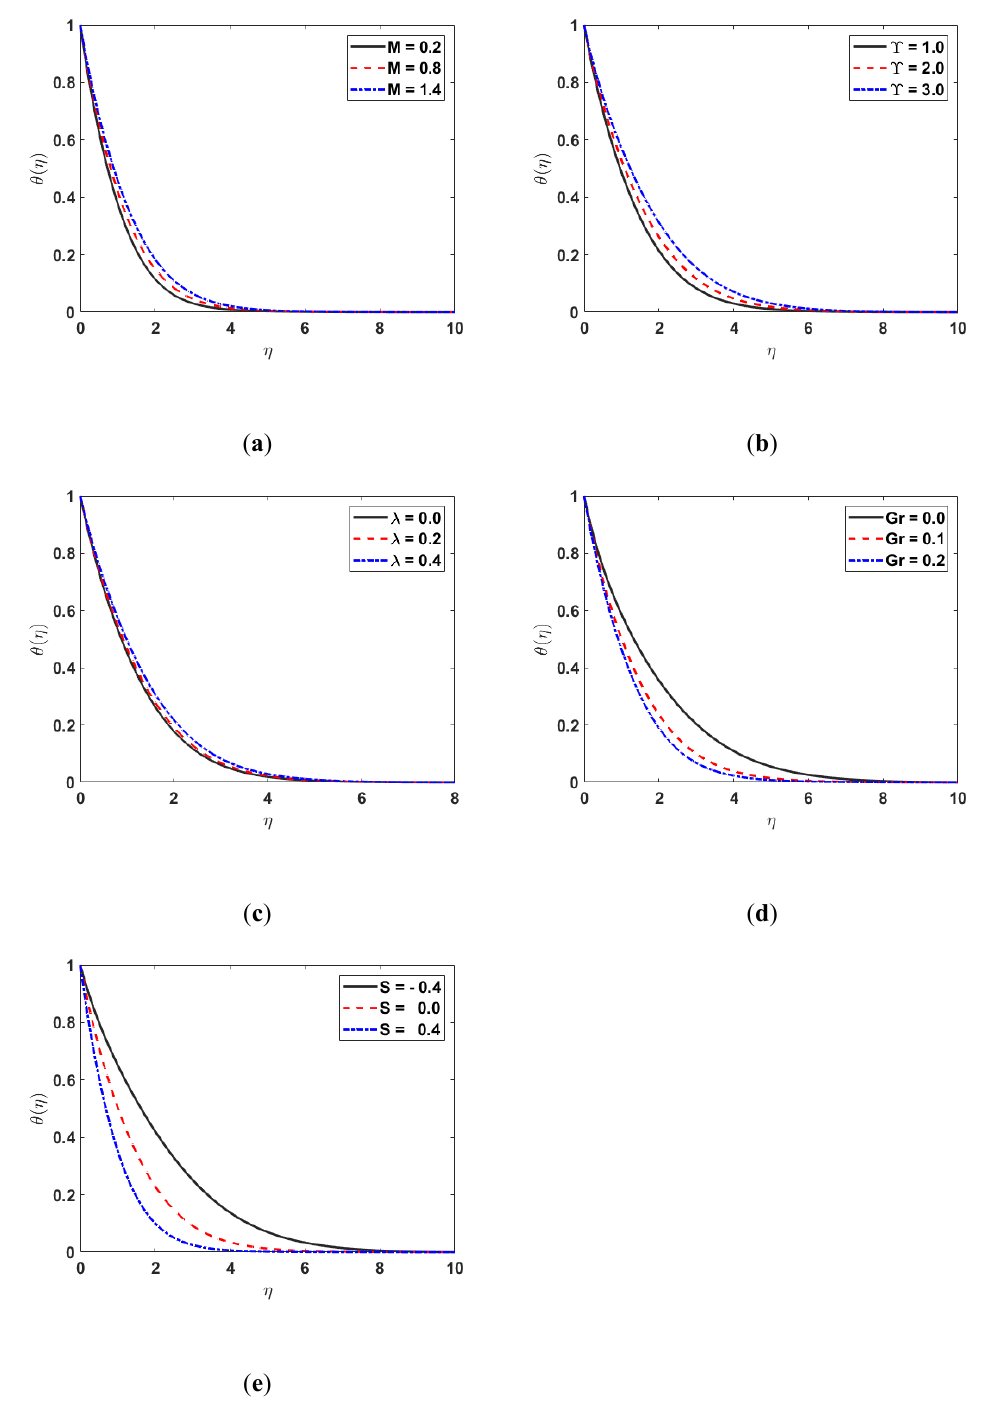
Figure 4. ( a ) 𝜃(cid:4666)𝜂 ) for different values of 𝑀 ; ( b ) 𝜃(cid:4666)𝜂(cid:4667) for different values of Υ ; ( c ) 𝜃(cid:4666)𝜂(cid:4667) for various Figure 4. ( a ) θ ( η ) for different values of M ; ( b ) θ ( η ) for different values of Y; ( c ) θ ( η ) for various values of 𝜆 ; ( d ) 𝜃(cid:4666)𝜂(cid:4667) along 𝐺𝑟 ; ( e ) 𝜃(cid:4666)𝜂(cid:4667) along 𝑆 . values of λ ; ( d ) θ ( η ) along Gr ; ( e ) θ ( η ) along S